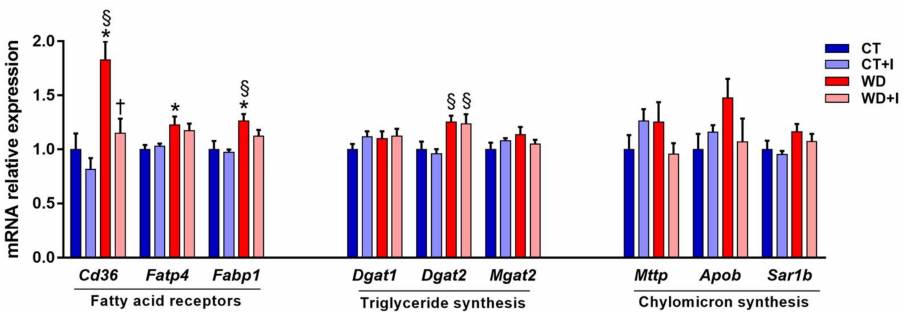
Figure 3. mRNA relative expression of genes involved in fatty acid absorption in the jejunum. Data are presented as mean ± SEM and analyzed with two-way ANOVA followed by Tukey post hoc tests. * p < 0.05 versus CT, § p < 0.05 versus CT + I, † p < 0.05 versus WD.